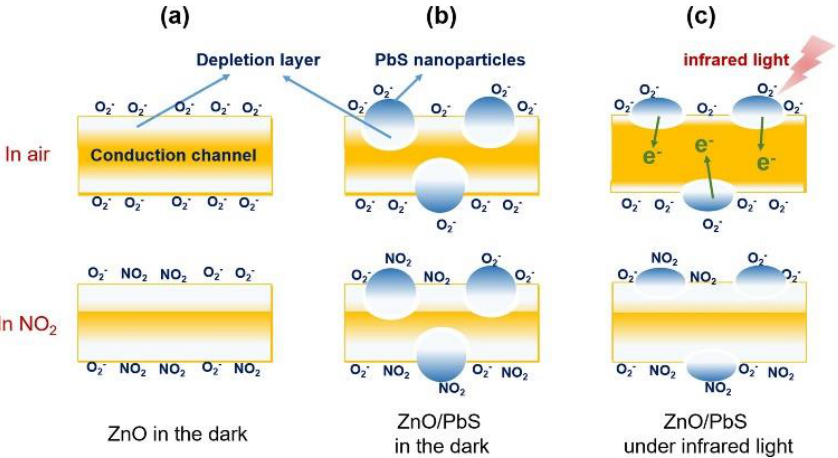
Figure 15. Schematic sensing mechanism of ( a ) ZnO in the dark; ( b ) ZnO/PbS in in the dark; ( c ) under NIR illumination [125].